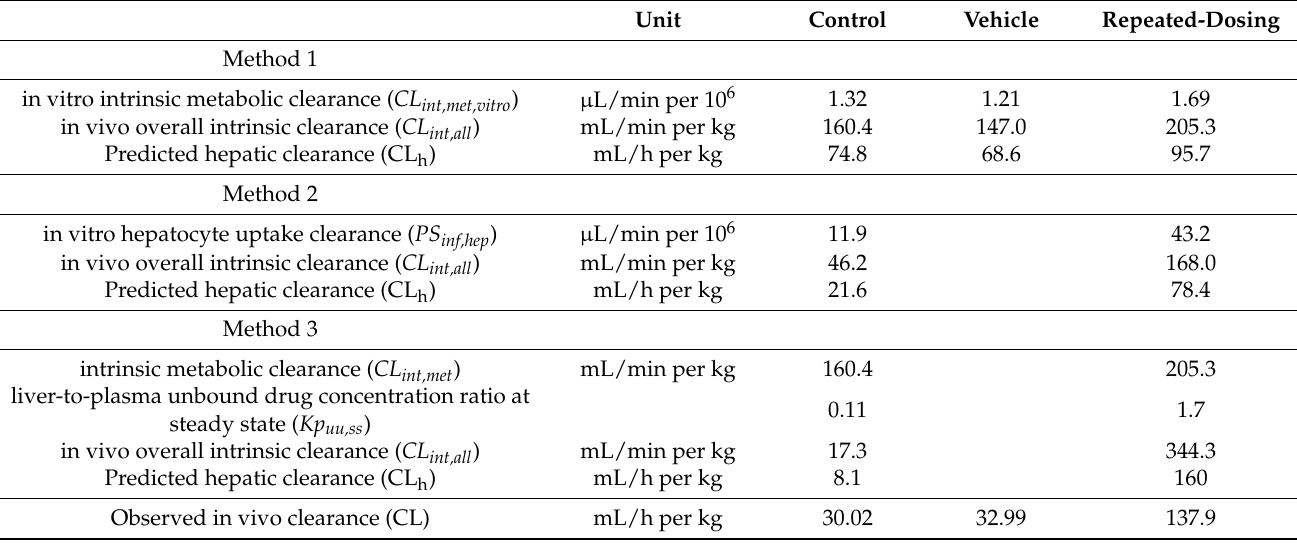
Table 2. Predicted and observed hepatic clearance calculated using IVIVE Methods 1, 2, and 3.